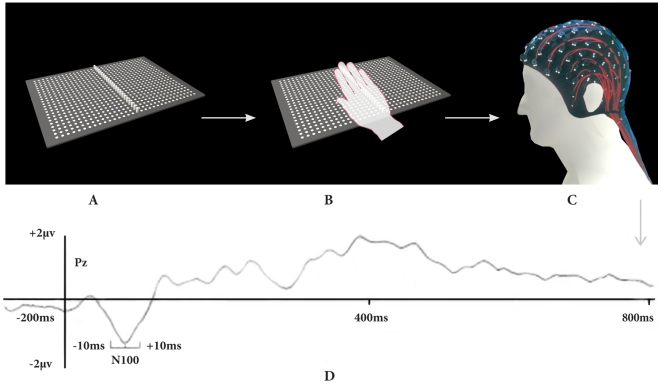
Experimental protocol and analysis of N100 component in Pz electrode.(A) A tactile piezoelectric device with 1536 stimulation points of stimulation is used (B) on the dominant hand, being applied on the palm. (C) EEG is then recorded with a 32 channel-cap. (D) The electrophysiological response of the evoked potential N100 component was measured in each task. Only frequent stimuli responses were analyzed. The time frame to analyze the N100 component was 80–140 ms and it was determined by searching for the maximal amplitude in the respective time window at the Pz electrode. The LORETA analysis was made opening a time window of −10 to +10 ms starting from the high amplitude pick measured in Pz electrode.